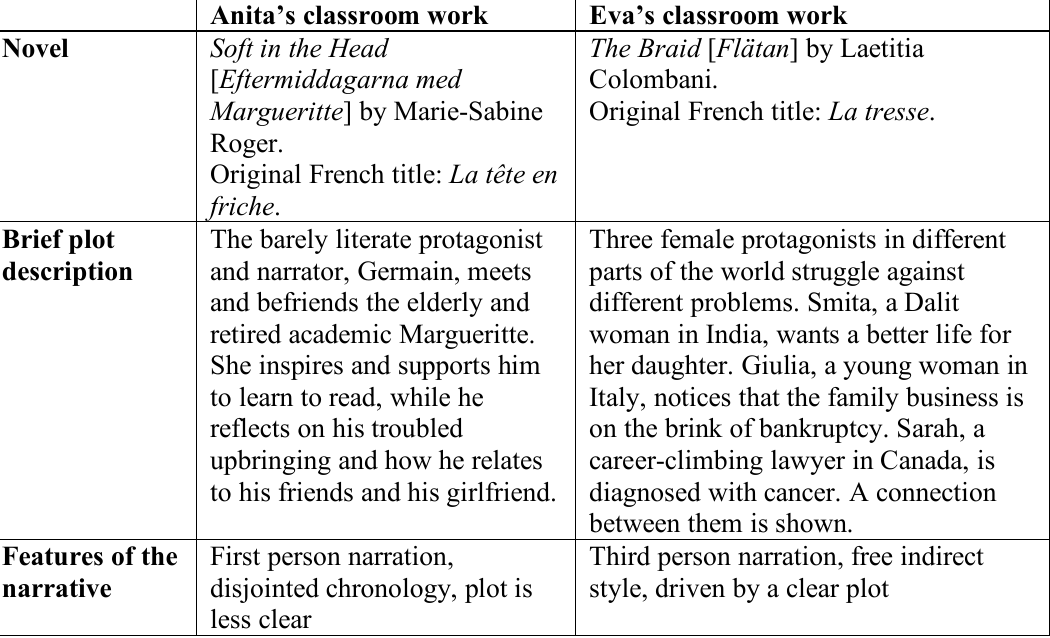
Table 2: Novels used in classroom work Anita’s classroom